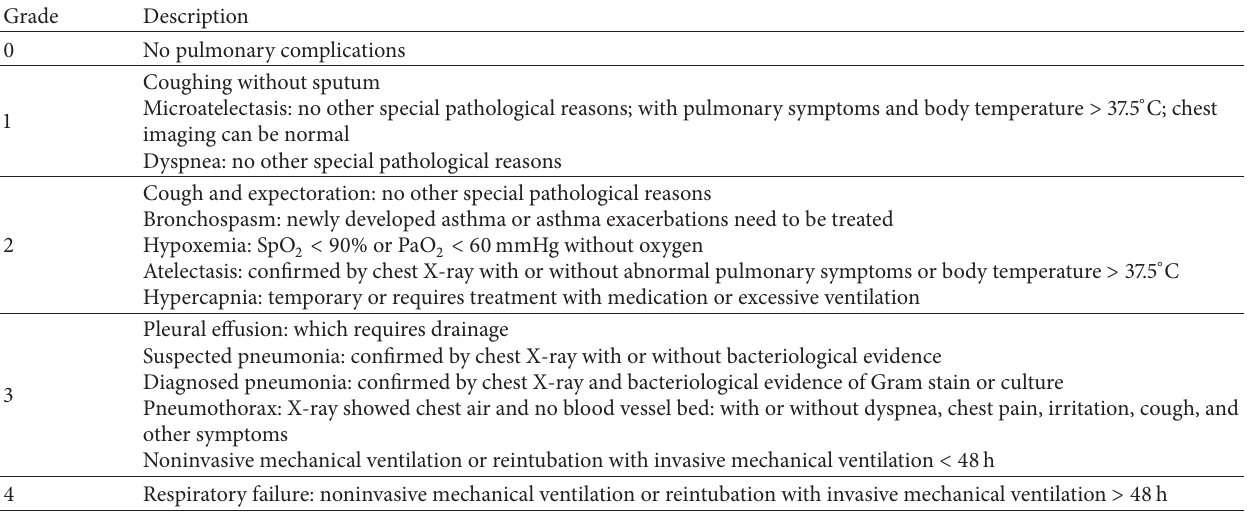
Table 1: Diagnosis of postoperative pulmonary complications.